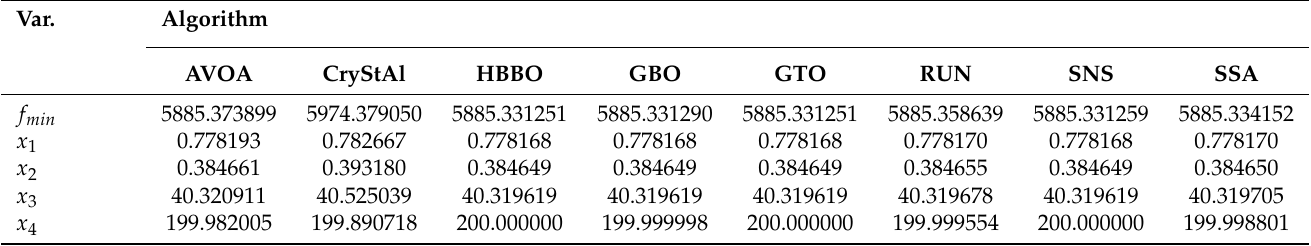
Table 9. Best optimum solution of each algorithm for the cylindrical pressure vessel design optimisation problem. Var.